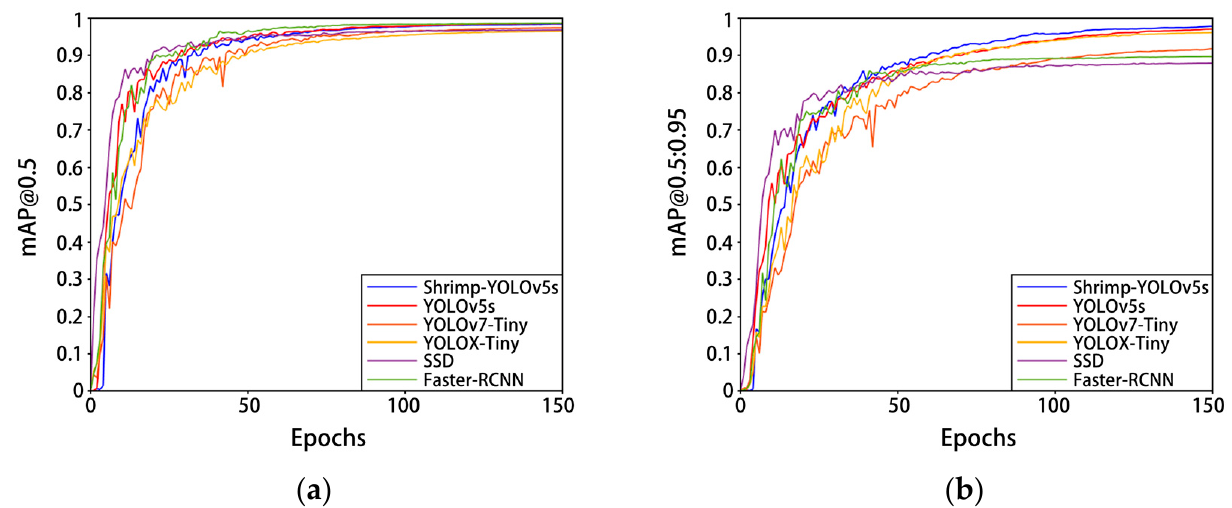
Figure 11. Experimental results of different models on the Penaeus vannamei dataset. ( a ) The change in curve in mAP@0.5; ( b ) the change in curve in mAP@0.5:0.95. Table 5. Comparison of six models on dataset of Penaeus vannamei. Model